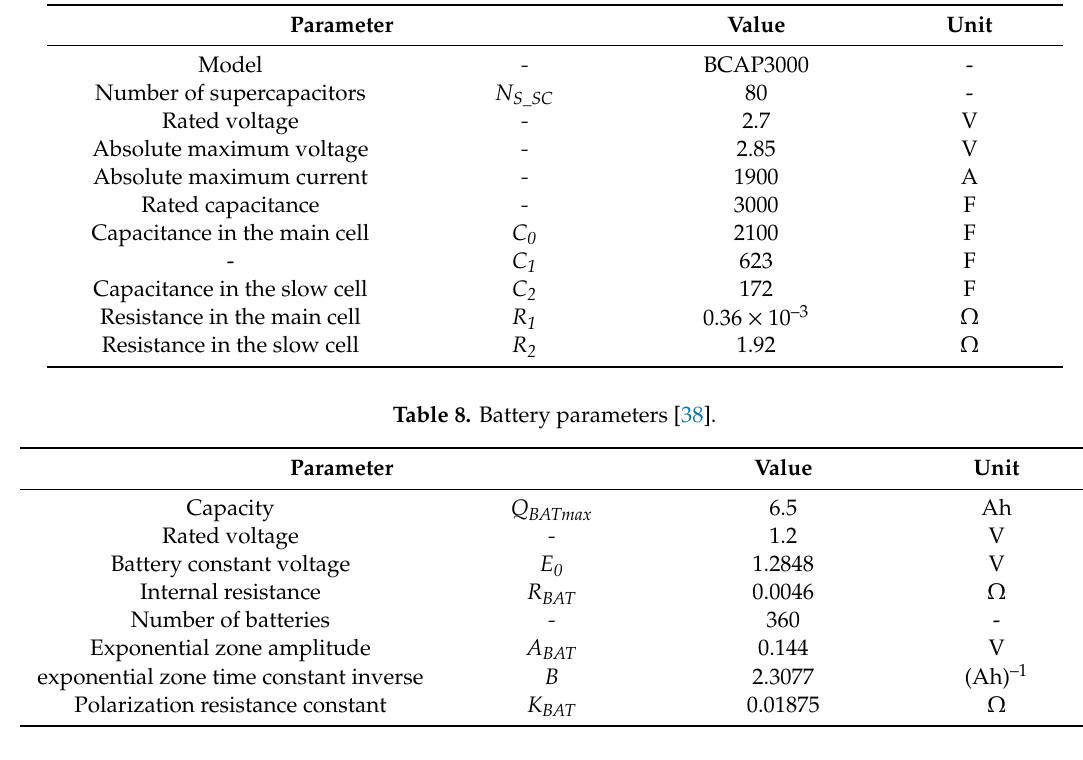
Table 7. Supercapacitor parameters [52].